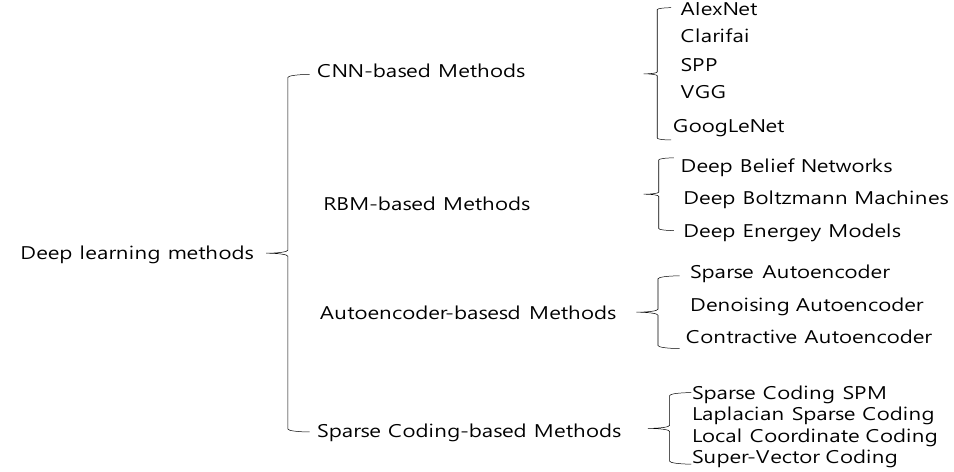
Figure 2. Categorization of the deep learning methods and their representative works.